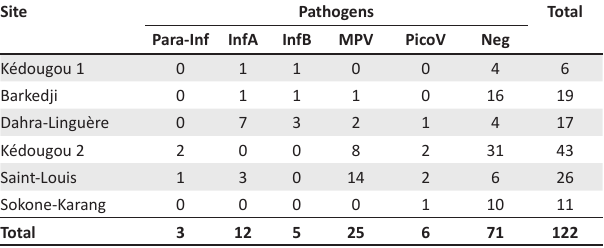
TABLE 2: Distribution of nasopharyngeal swab samples collected and pathogens identified in Kédougou, Barkedji, Dahra-Linguère, Saint-Louis and Karang-Sokone areas, October 2017–March